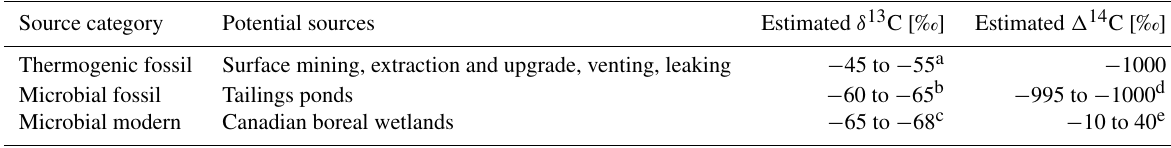
Table 1. Estimated values of δ 13 CH 4 and (cid:49) 14 CH 4 for the three source categories used in the source attribution. Source